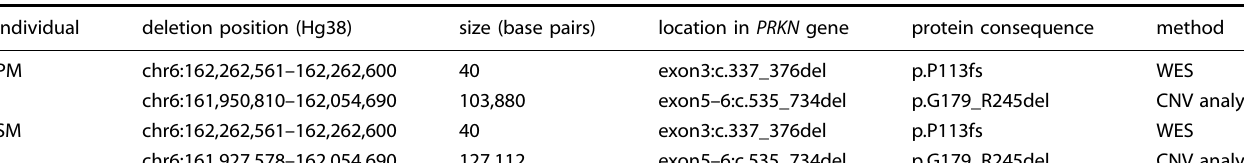
Table 1. PRKN Deletion Coordinates in PD Brothers.